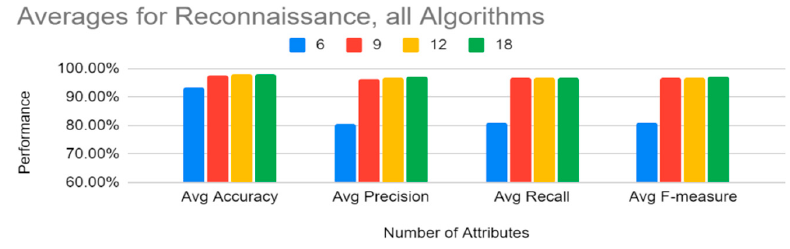
Figure 12. Reconnaissance: Averages for All Algorithms by Number of Features.